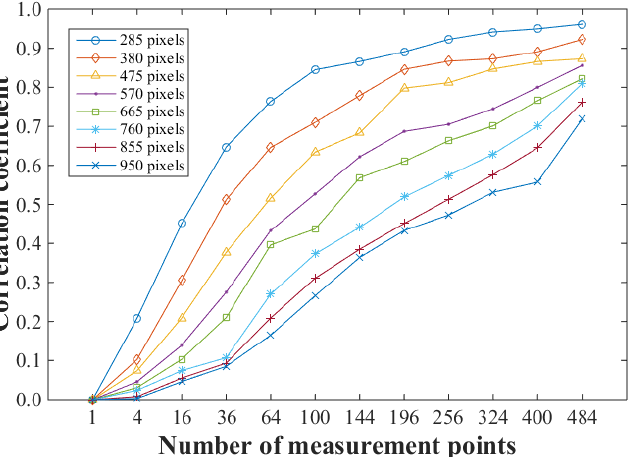
Figure 7. Correlation coefficients of optical-turbulence errors between measurement points on different targets.